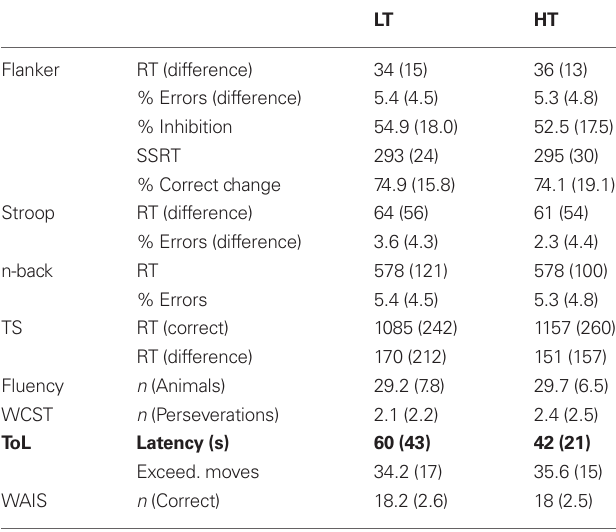
Table 1 | Results of executive functions test battery (Study 1).